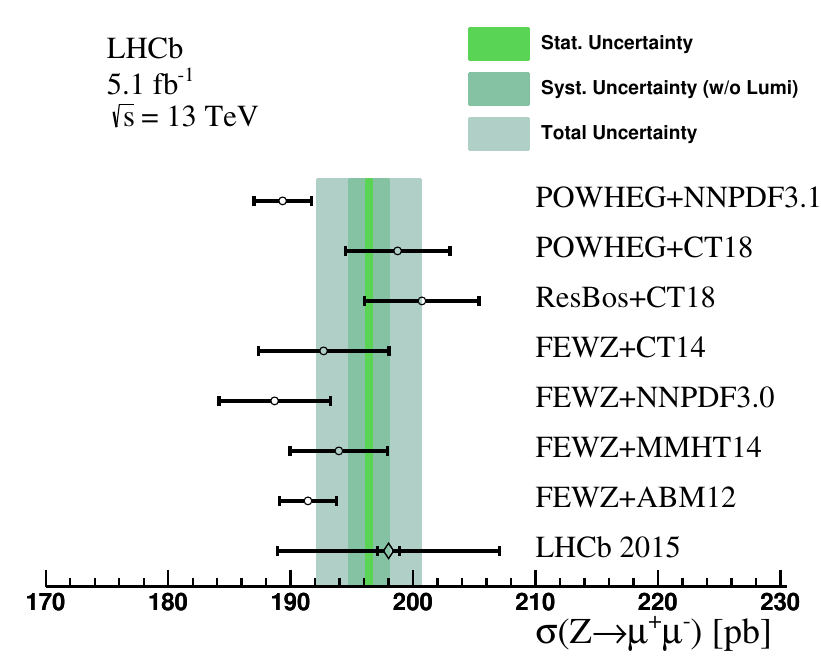
Figure 10 . Comparison of the integrated cross-section, σ , between data and theoretical Z → µ + µ − predictions. The bands correspond to the data, with the inner band corresponding to the statistical uncertainty and the outer bands corresponding to the systematic uncertainty and total uncertainty. The open circles correspond to the different theoretical predictions. The diamond point corresponds to the previous LHCb measurement